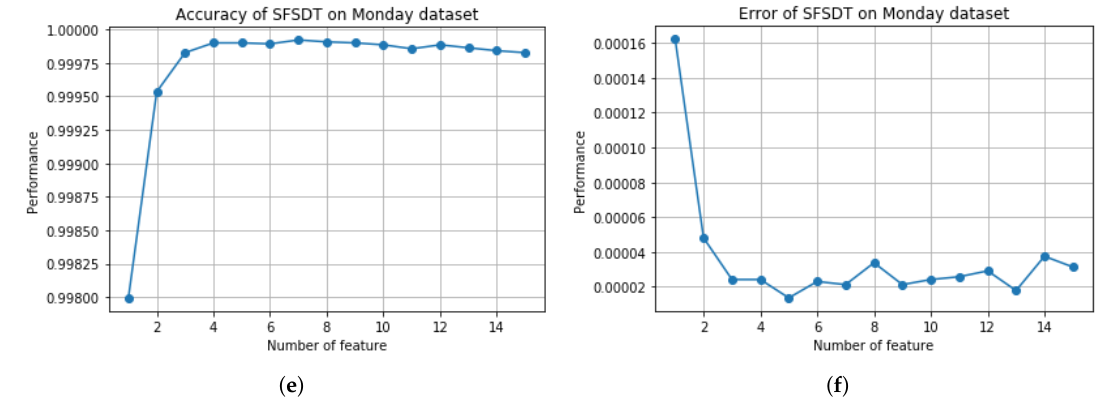
Figure 10. Visualization accuracy and error scores of SFSDT model on each day of ISCX dataset. ( a ) &